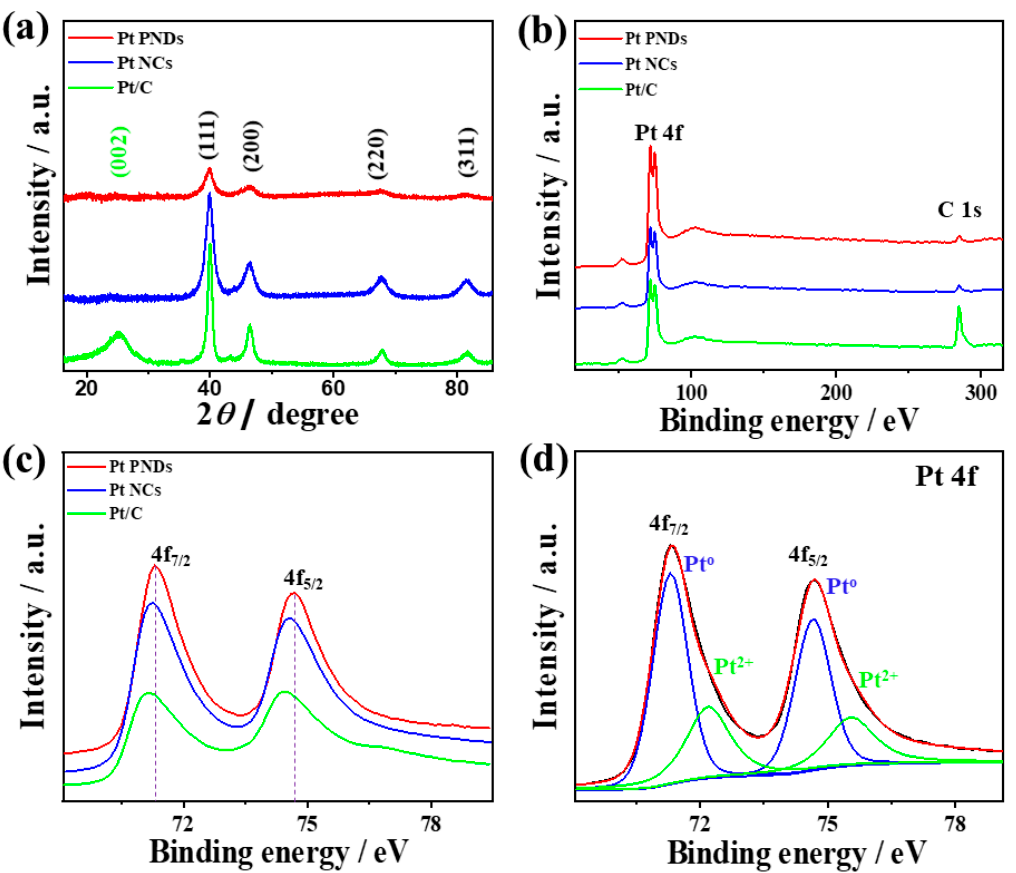
Figure 2. ( a ) XRD, ( b ) XPS survey ( c ) high-resolution spectra of Pt 4f in Pt NDs, Pt NCs, and Pt/C. ( d ) Fitting of Pt 4f spectra I Pt